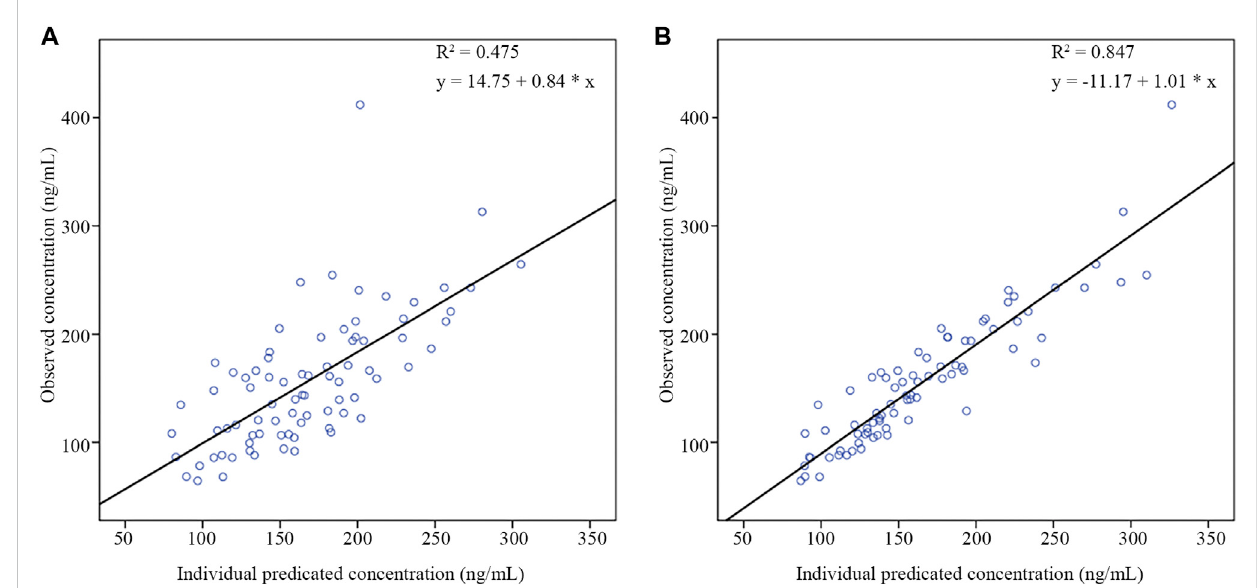
FIGURE 6 The scatter plots of external validation of the fi nal nalbuphine model. (A) external evaluation dataset without observations; (B) external evaluation dataset within the fi rst observation of each subject.